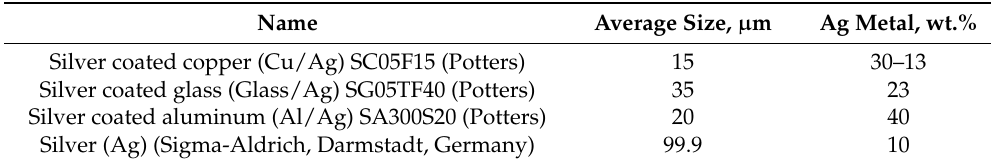
Table 2. Conductive particles specification.